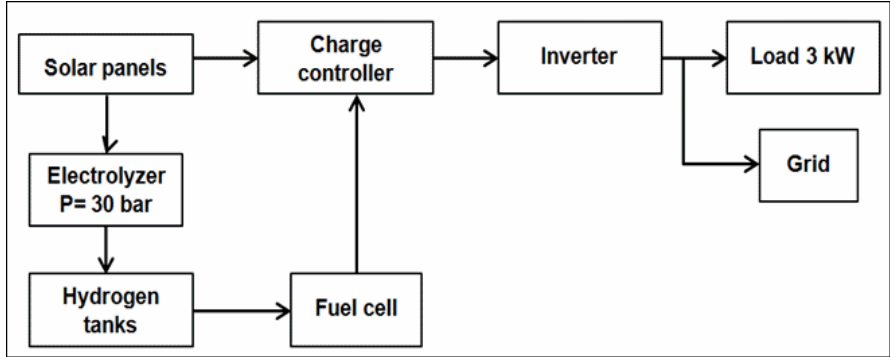
Figure 2. Scheme of the fuel cell-based stationary system.